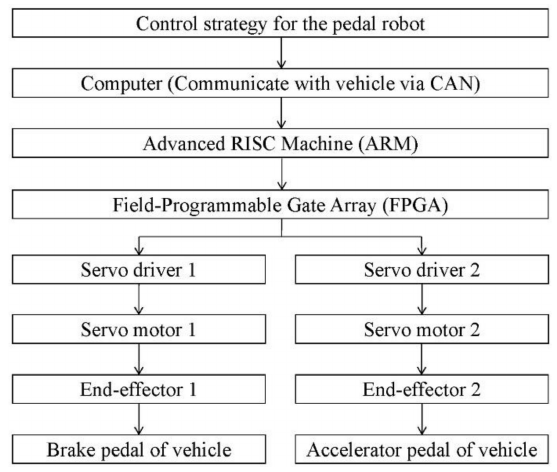
Figure 4. Procedures of robot control.